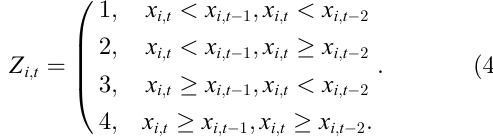
: clients in I : maximal d max attained by I (cid:6) i , d i i